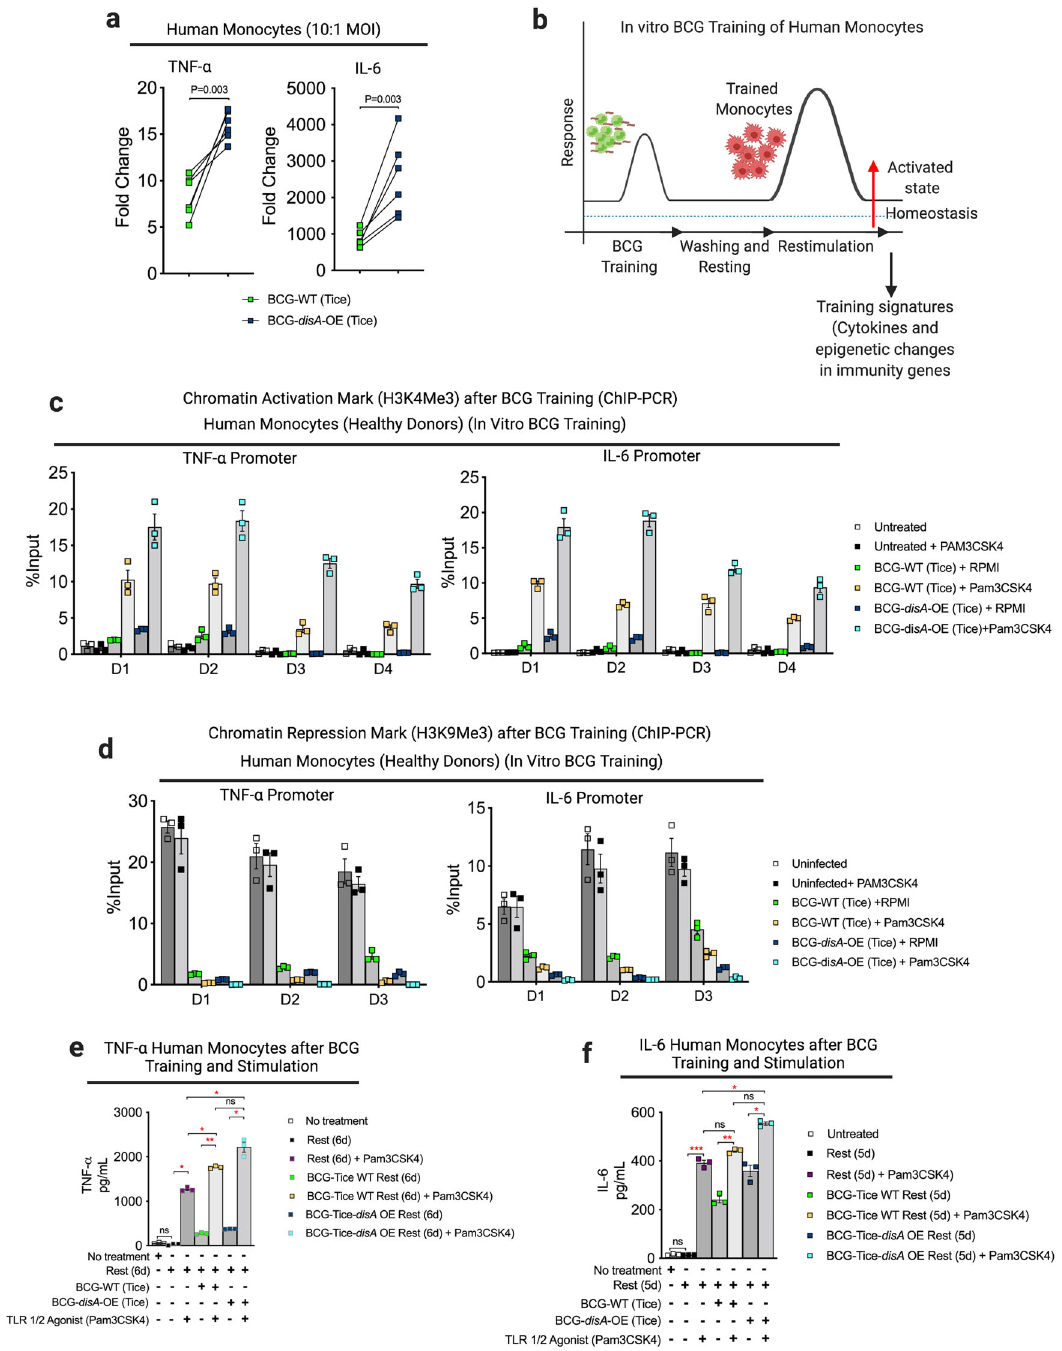
Fig. 3 Compared with BCG-WT, BCG- disA -OE is a more potent inducer of epigenetic changes characteristic of trained immunity in primary human monocytes. a mRNA levels of TNF- α and IL-6 in primary human monocytes ( n = 6 healthy donors) relative to RNU6A after 24 h exposures at a MOI of 10:1. Statistical analysis done using multiple unpaired t-test with Bonferroni-Dunn method. b Schematic diagram of in vitro monocyte training. c Relative levels of the H3K4me3 chromatin activation mark ( n = 4 healthy donors; D1 – D4) or d the H3K9me3 chromatin repression mark retrieved from TNF- α and IL-6 promoter regions of primary human monocytes from 3 ( n = 3) health donors (D1 – D3) determined by ChIP-PCR assay on day 6. e , f Secreted cytokines (TNF- α and IL-6) following BCG training and re-stimulation. Monocytes were initially challenged on day 0 with a 24 h exposure to the BCG strains at a MOI of 10:1 followed by washing. After 5 days of rest, they were treated for 24 h with either a sham stimulus (RPMI) or the TLR1/2 agonist Pam3CSK4 ( n = 3 healthy donors). Data are presented as mean values ± S.E.M. Statistical analyses done using two-tailed Student ’ s t -test (* P < 0.05, ** P < 0.01, *** P < 0.001, **** P <